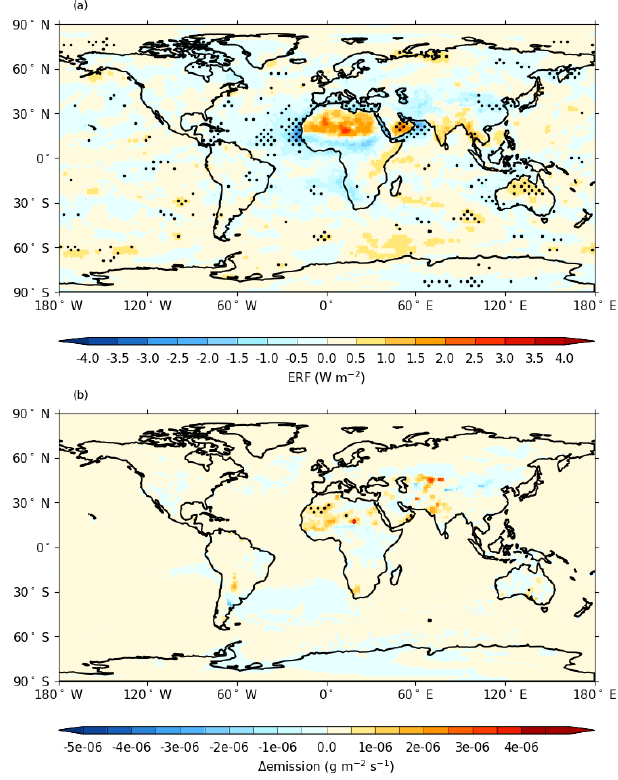
Figure 1. Multi-model mean (a) ERF from piClim-2xdust vs. piClim-control , (b) change in dust emissions for abrupt-4xCO2 vs. piControl . Stippling shows areas where the mean changes by more than the standard deviation across